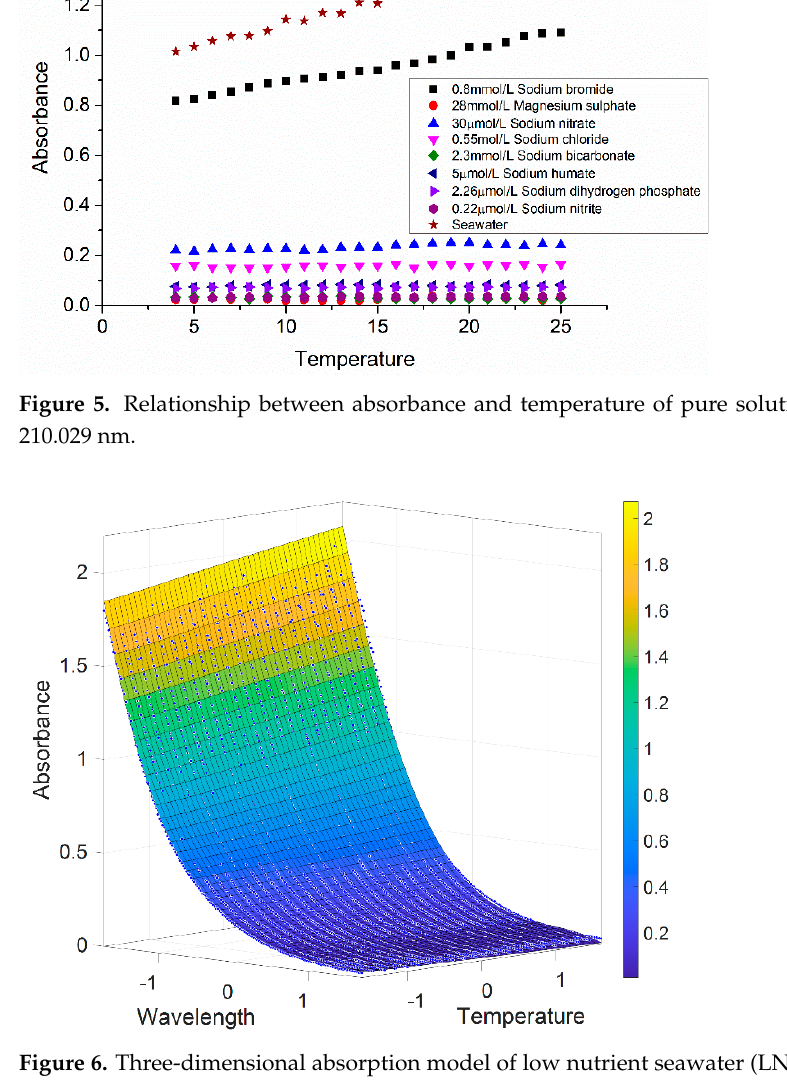
− mean ( t ) and std ( t )